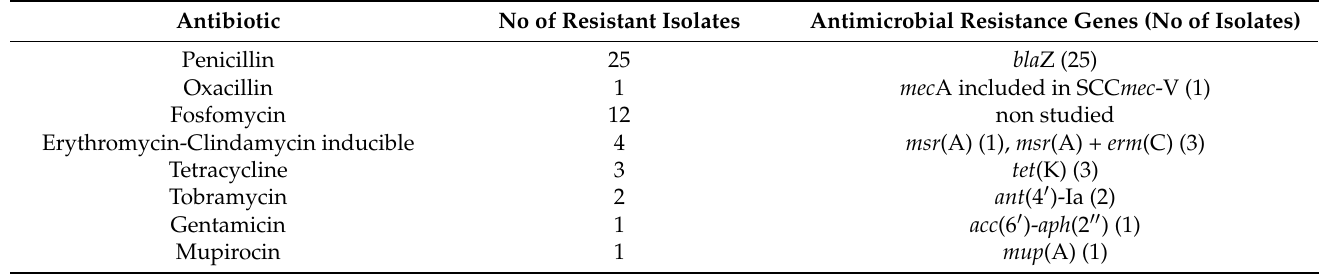
Table 2. Antimicrobial resistance phenotypic and genotypic correlation for all the antibiotics